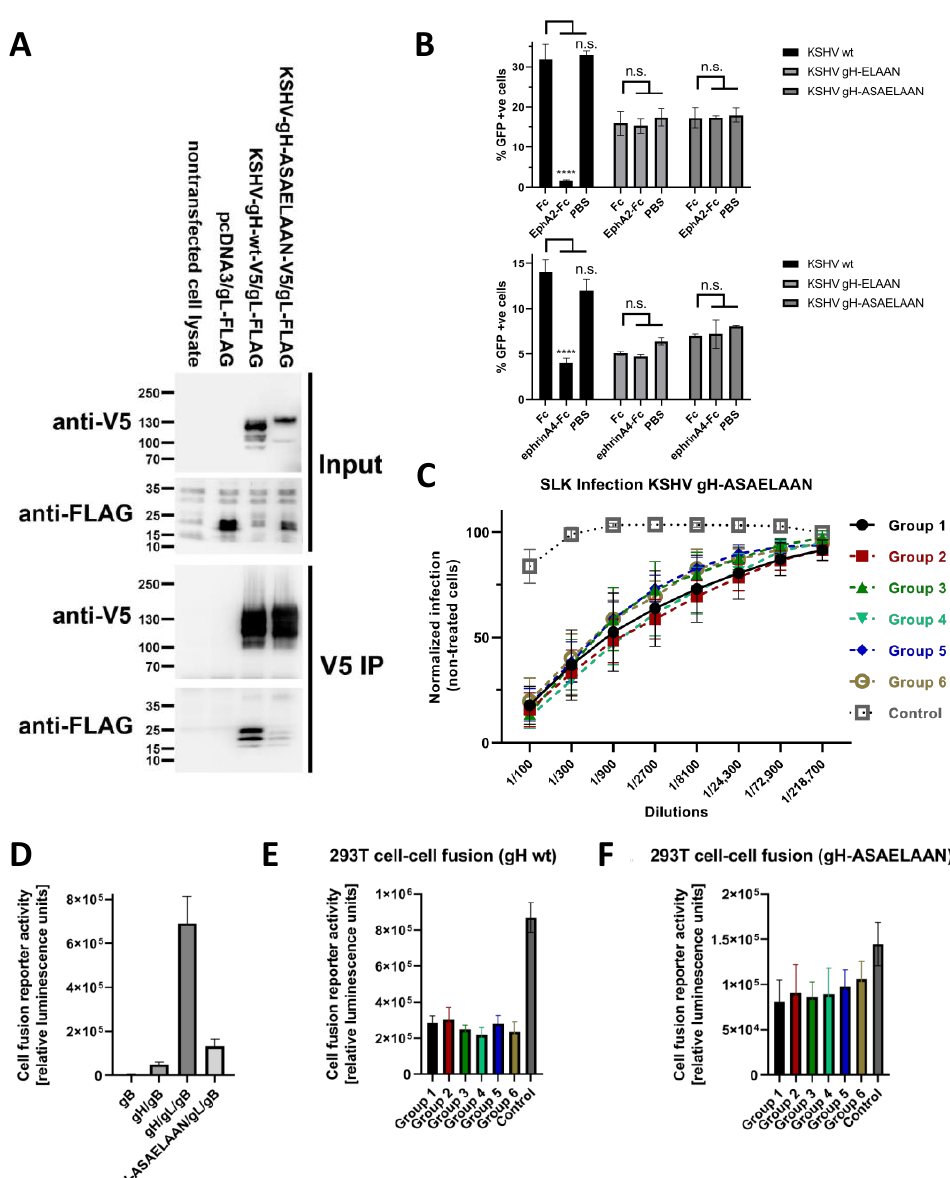
Figure 4. Inhibition of an Eph-detargeted KSHV mutant by sera directed against gH/gL. ( A ) V5 immunoprecipitation of KSHV gH-V5/gL-FLAG and KSHV gH-ASAELAAN-V5/gL-FLAG. The samples were analyzed by Western blot and detected with the indicated antibodies. ( B ) KSHV gH-ASAELAAN is refractory to inhibition with soluble EphA2-Fc decoy receptor (upper panel) or inhibition with soluble ephrinA4-Fc (lower panel). The experiment was performed in triplicate (**** indicates p < 0.0001 compared to Fc; two-way ANOVA, Sidak correction for all multiple comparisons). ( C ) Neutralizing activity of mice sera at 63 days against KSHV gH-ASAELAAN. No significant differences were observed between Groups 2 – 6 and Group 1 (extra sum-of-squares F test after non-linear fit for different IC50, inhibitor vs normalized response model; no correction for multiple comparisons). The experiment was performed three times; infection was normalized to infection without mouse serum and averaged for each serum. Sera from individual mice were treated as biological replicates and averaged values of the five sera of each group are shown. Error bars represent the standard deviation. Sera from all groups inhibited significantly compared to the control sera ( p < 0.0001; two- way ANOVA; Dunnett’s method for correction for multiple comparisons). ( D ) Cell – cell fusion assay. Cells transfected with KSHV gH-ASAELAAN/gL/RRV gB fuse 5 fold less with the target cells than KSHV gH/gL/RRV gB. Error bars represent the standard deviation. ( E ) Cell – cell